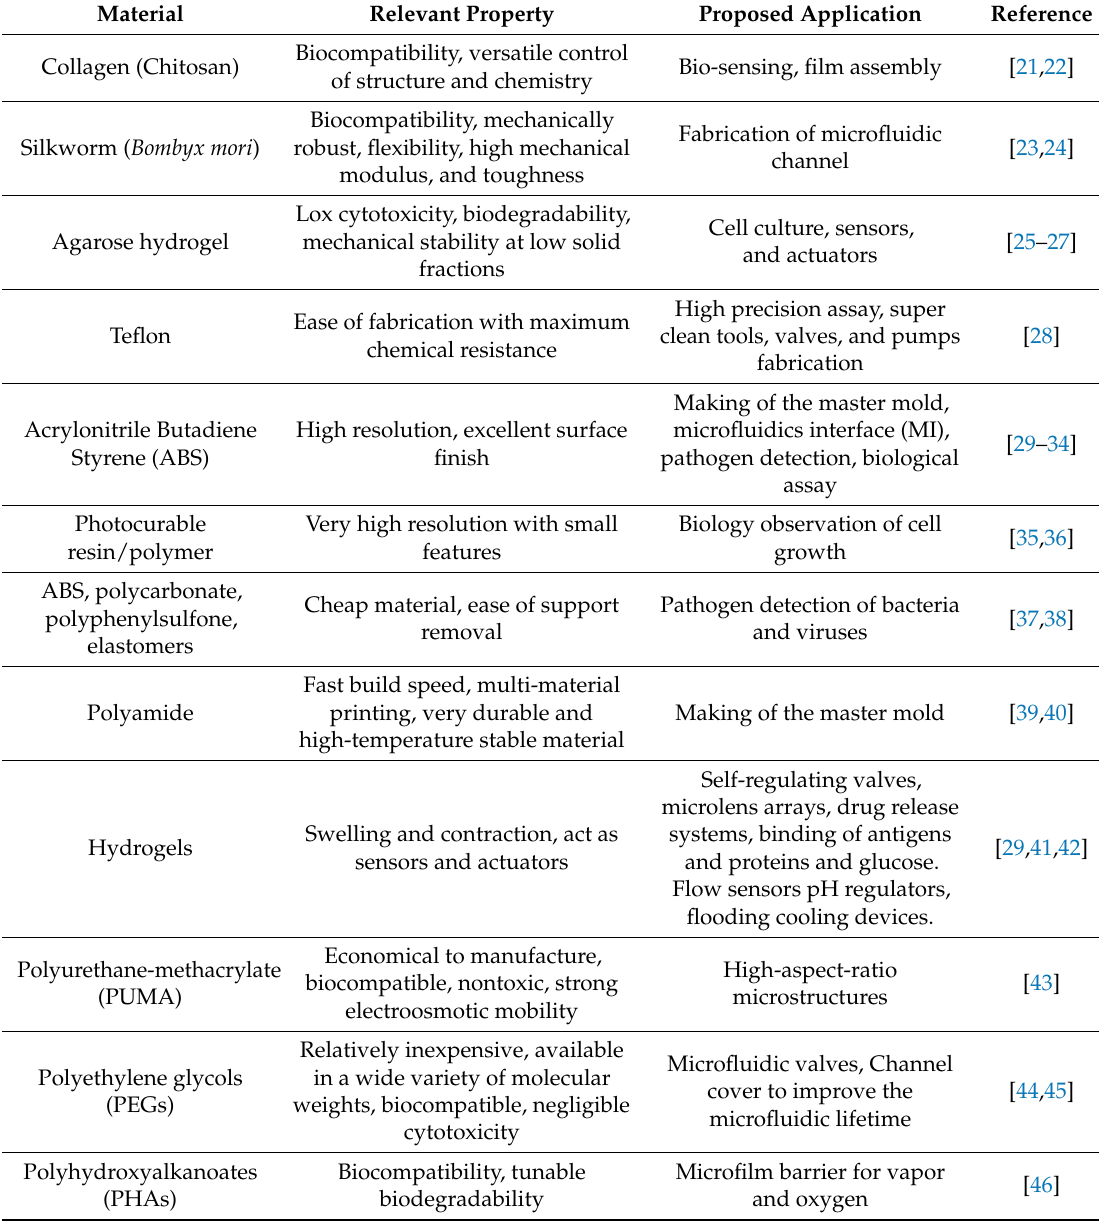
Table 1. Potential materials used in